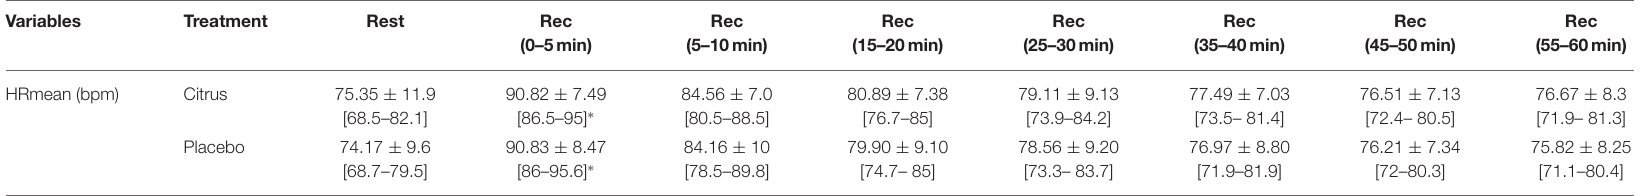
TABLE 2 | Mean heart rate values followed by standard deviations [confidence interval 95%] before and post-exercise in individuals during experimental protocols. Variables